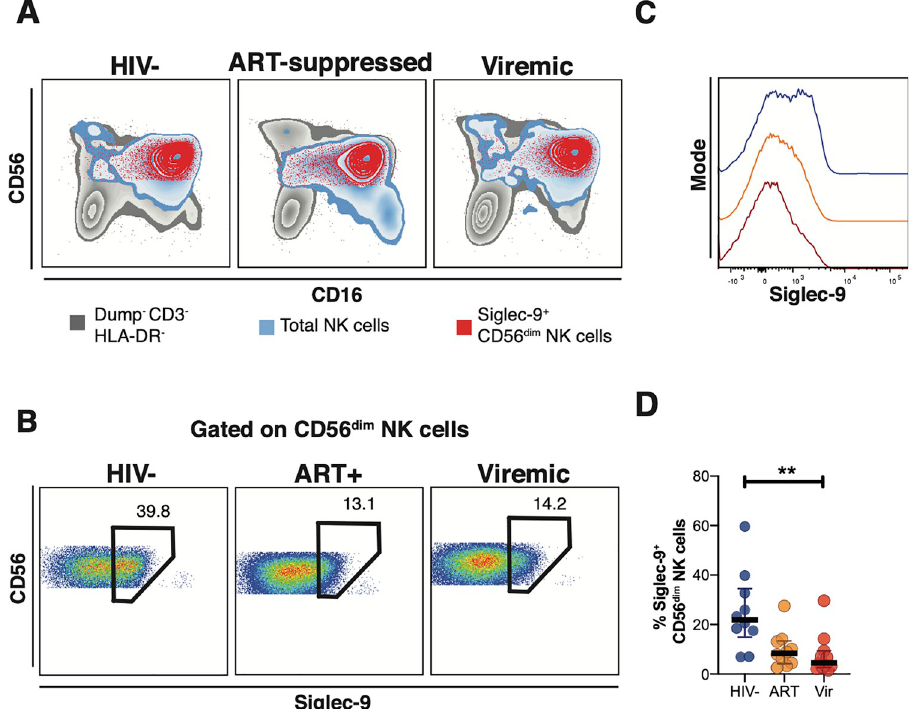
Fig 1. Expression of Siglec-9 + CD56 dim NK cells during HIV infection. (A) Overlay plots showing the distribution of Siglec-9 + CD56 dim NK cells (red) compared with total NK cells (blue) and non-T cell lymphocytes (grey). (B-C) Representative plots showing the frequency (B) and expression (MFI overlay) (C) of Siglec-9 in total CD56 dim NK cells in HIV- (blue line), HIV+ ART+ (orange line), and HIV+ viremic (red line) individuals. (D) Decreased frequency of Siglec-9 + CD56 dim NK cells during HIV infection compared to HIV- controls. Lines in graphs indicate the median of the group. �� p < 0.01. Mann-Whitney rank test was used to compare between groups. n = 10 HIV-negative controls, 11 HIV+ viremic, and 10 HIV+ on suppressive